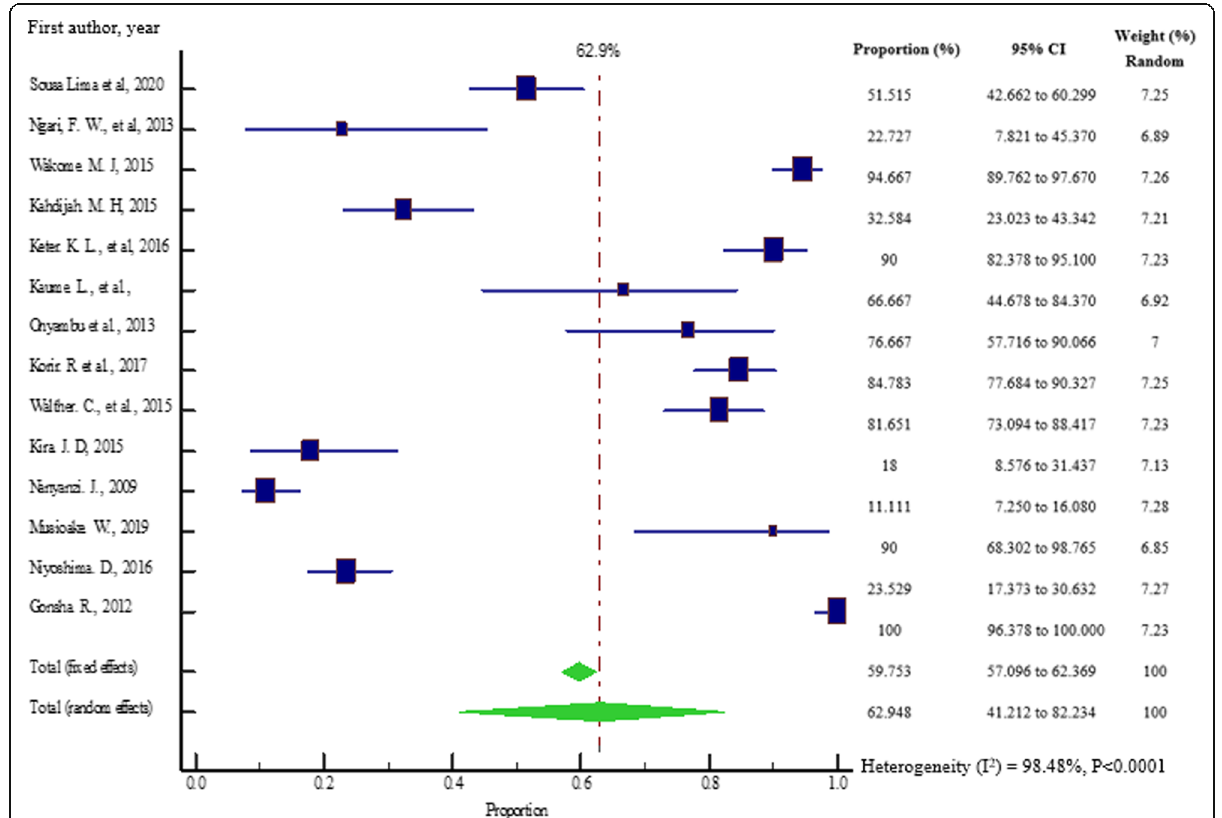
Fig. 2 Pooled prevalence estimates of bacterial contamination in herbal medicines sold in East African countries from the year 2000 to 2020, using random effects